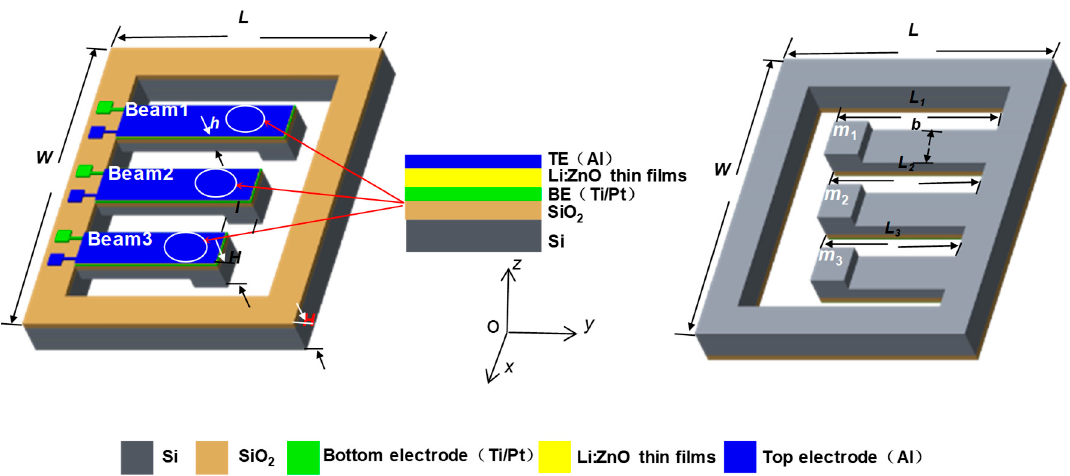
Figure 1. Basic structure of energy harvester with cantilever beam: ( a ) front view; ( b ) back view.